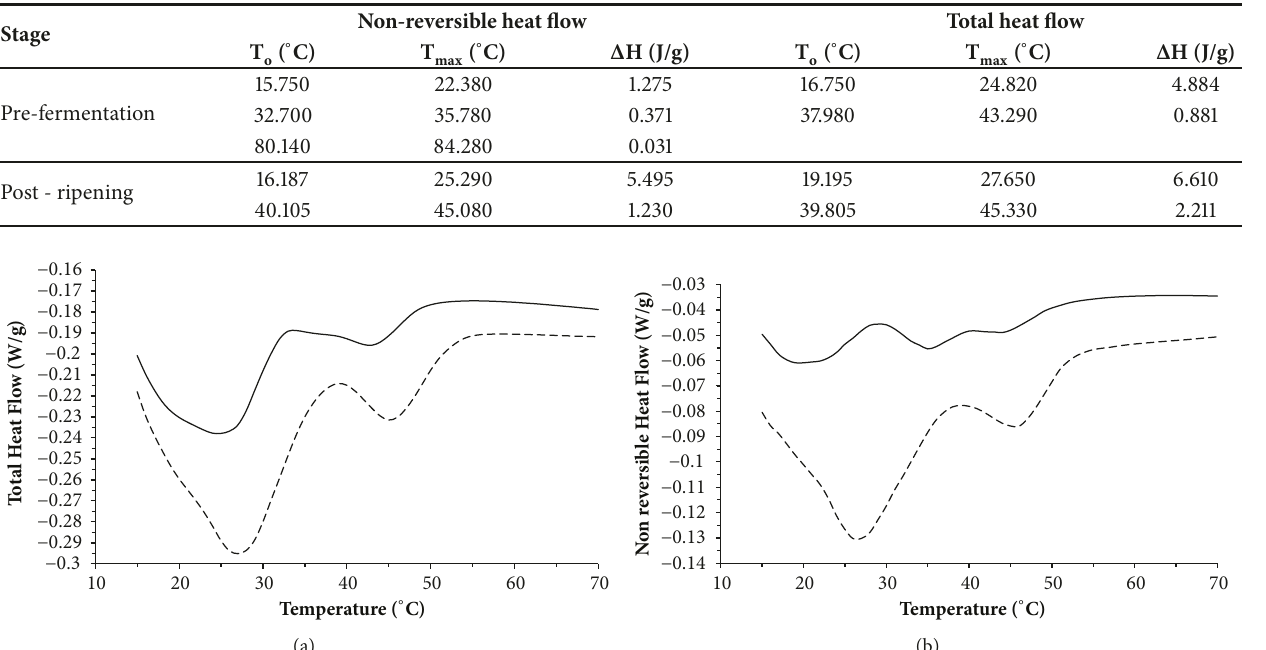
Table 2: Onset temperature of the endothermic peak (T treatment Ls-Sc + in the pre-fermentation and postripening stages.